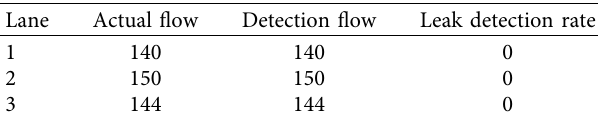
Table 3: Detection results at 7 o’clock in the evening when the ground induction coil+ video detection mode is used.